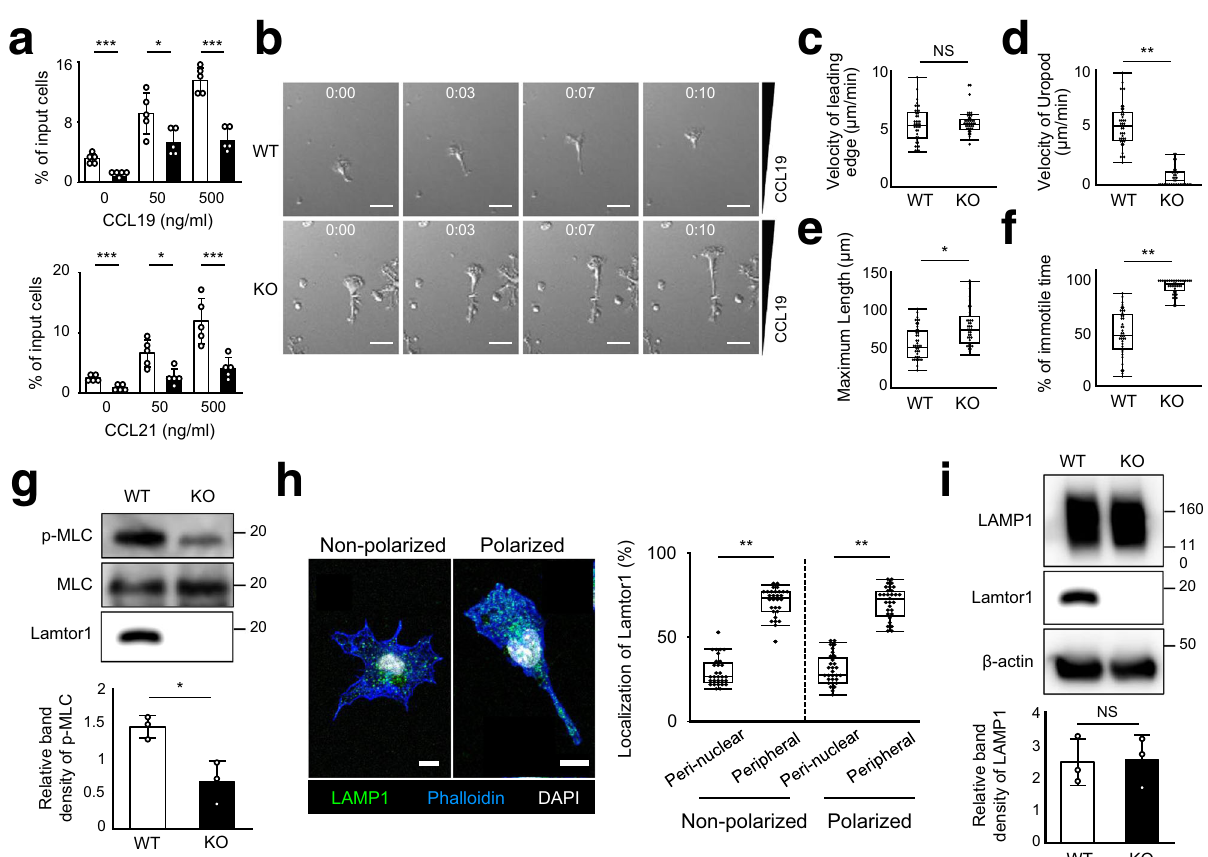
Fig. 2 Impairment of DC migration in constricted areas under Lamtor1 de fi ciency. a Chemotaxis of WT (white bar) and Lamtor1 − / − (black bar) BMDCs toward the indicated concentrations of CCL19 (upper) or CCL21 (lower) in a Transwell assay system (pore size, 5 μ m). Data are representative of three experiments. b – f Motility of DCs in response to CCL19 in 3D collagen matrices. Movement of WT (upper) and Lamtor1 – / – (lower) BMDCs in response to CCL19 (5 μ g/ml) in type I collagen gels (2 mg/ml) in a Zigmond chamber were observed at 1-min intervals by time-lapse video imaging. Velocities of